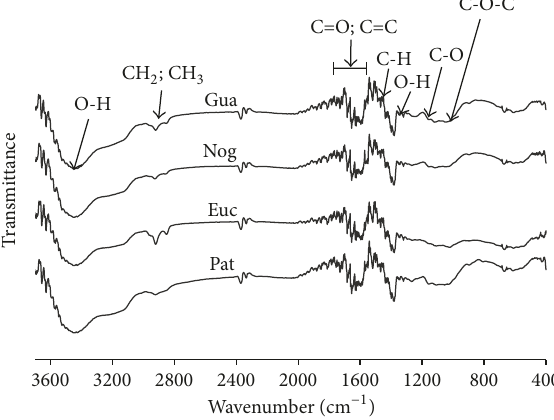
Figure 5: FTIR spectra of firewood species